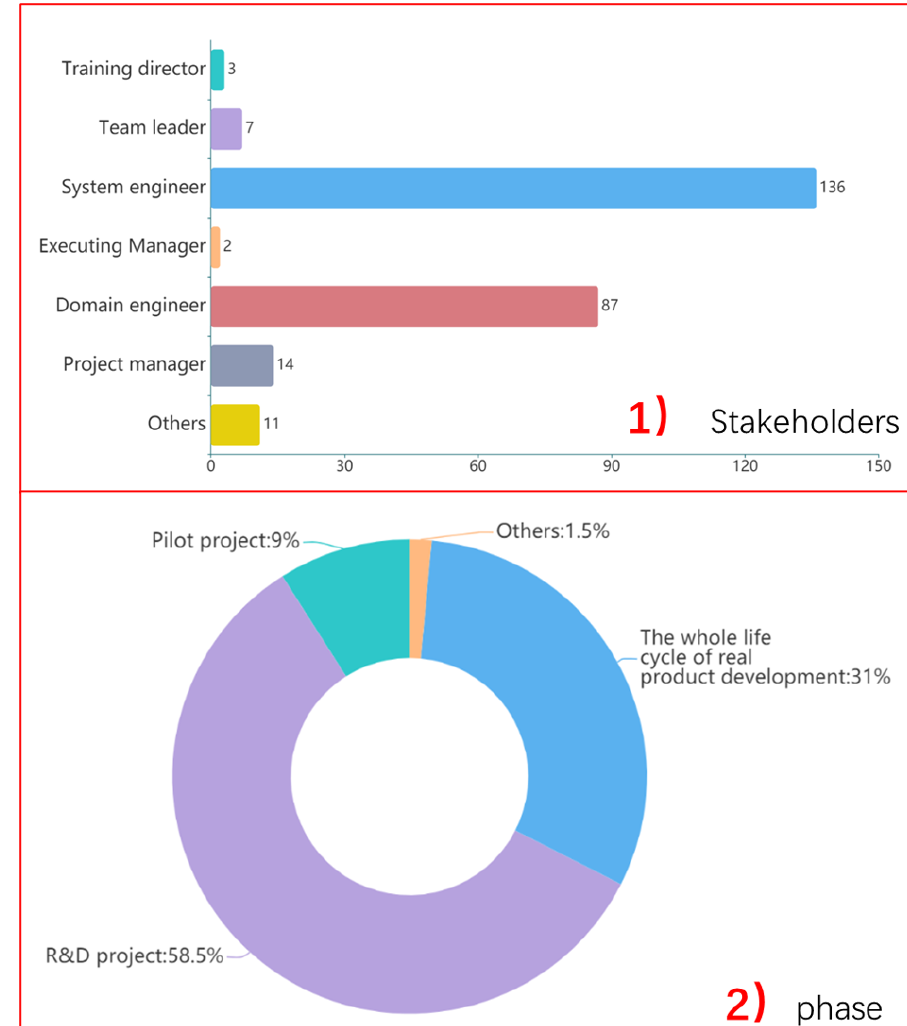
Figure 3. ( 1 ) The roles that the papers contributed to; ( 2 ) the development phases that the papers contributed